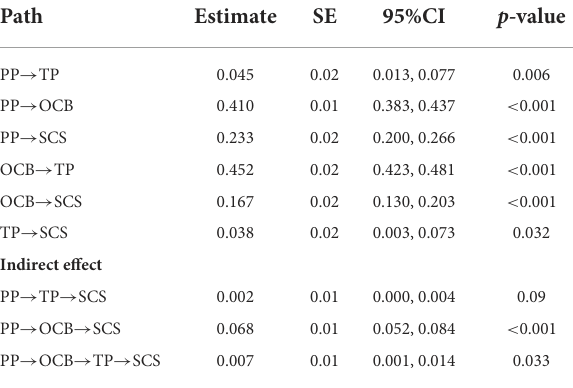
TABLE 4 Path coefficient for proactive personality and salary.